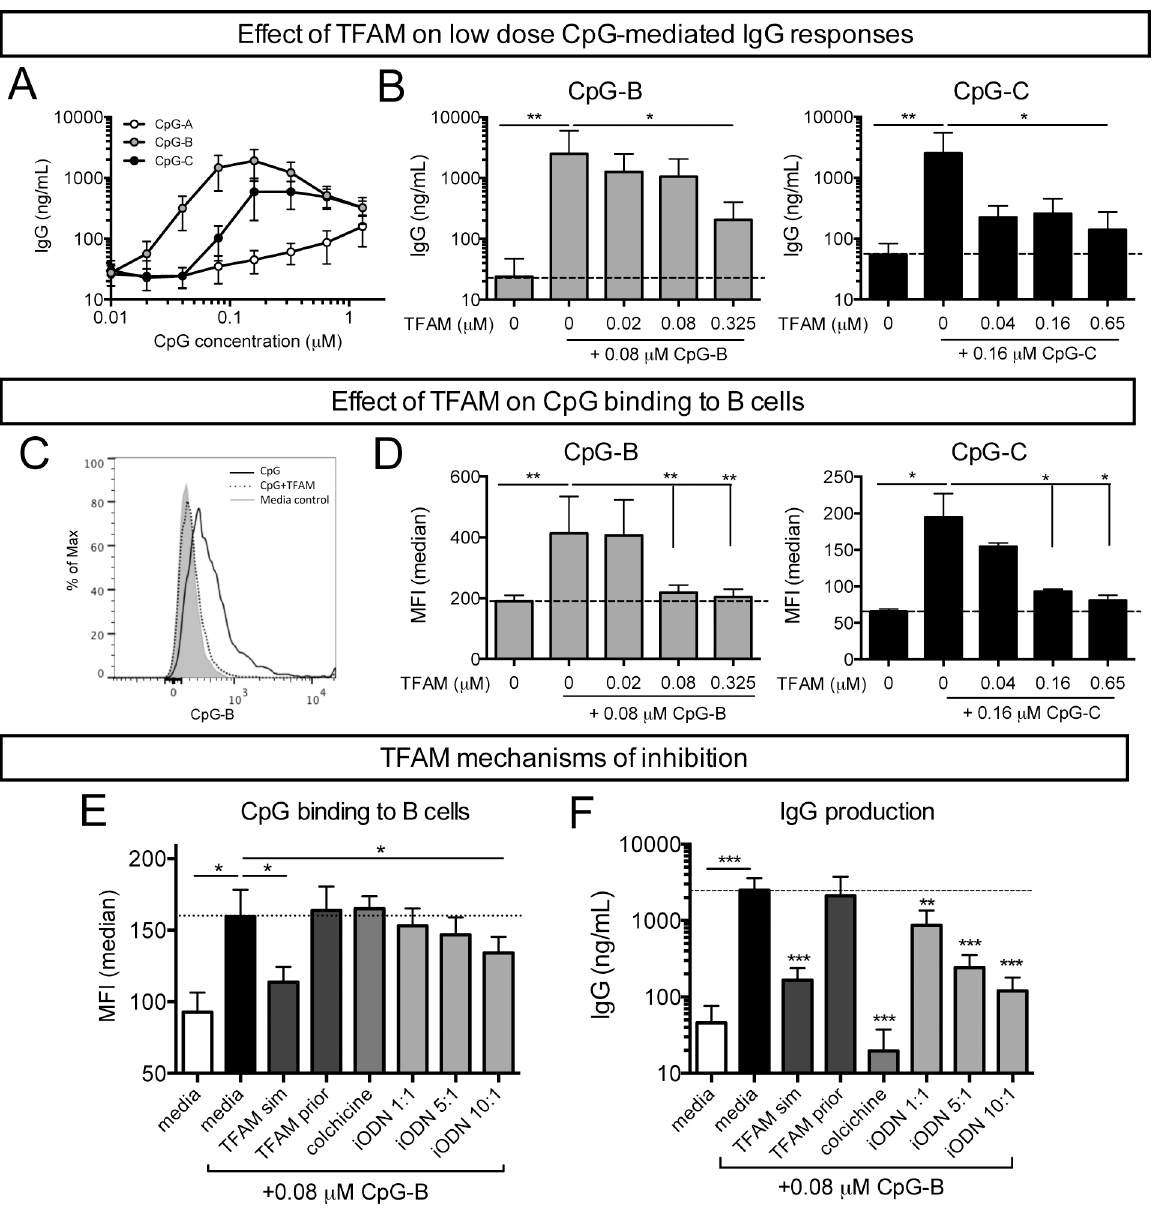
Fig 4. TFAM attenuates antibody production by preventing CpG binding to B cells. (A) IgG production by PBMCs (n = 3 – 5) stimulated with varying doses of CpG-A, -B or -C (PS) for 7 days. Mean ± S.E.M. (B) IgG production from PBMCs (n = 4) stimulated with CpG-B or -C with increasing concentrations of TFAM. Mean+S.D. (C) Representative flow cytometric histogram of FM-labeled CpG-B staining on CD19 + B cells in PBMCs after one hour incubation with CpG-B alone (0.08 μ M, black line), CpG-B (0.08 μ M) + TFAM (0.325 μ M, dotted line) or media control (gray filled). (D) Median fluorescence intensity (MFI) of FM-labeled-CpG-B (gray bars) or – C (black bars) staining on B cells in PBMCs (n = 7) after one hour of incubation with increasing concentrations of TFAM. P- values are compared to CpG only control. (E) MFI on B cells and (F) IgG production after PBMCs (n = 4) were stimulated with TFAM at the same time as CpG-B (TFAM sim; 0.325 μ M) or prior to CpG-B addition (TFAM prior; 0.325 μ M), colchicine (blocks CpG endocytosis; 150 ng/ml) or a TLR9 antagonist (iODN, blocks TLR9 signaling by outcompeting CpG for binding; molar ratios of iODN to CpG-B). Mean+S.D. * P < 0.05, ** P < 0.01, *** P < 0.001. (PS) were limited so this class was not tested further. Based on the dose response curves, we stimulated PBMCs with a low dose of CpG-B and -C (PS) (0.08 μ M and 0.16 μ M, respectively)